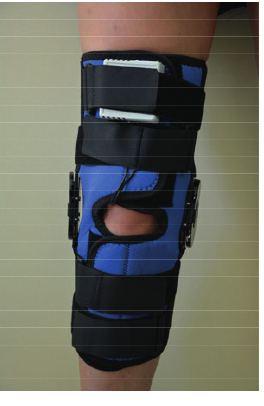
Figure 1. Knee brace with laser Maximal voluntary isometric and concentric